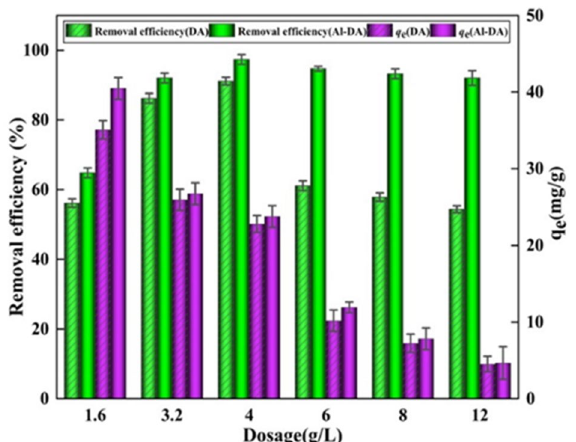
Figure 10. Effect of the dosing quantity of DA and Al-DA on the adsorption of F − (fluoride initial concentration is 100 mg/L, pH 6, contact time is 2